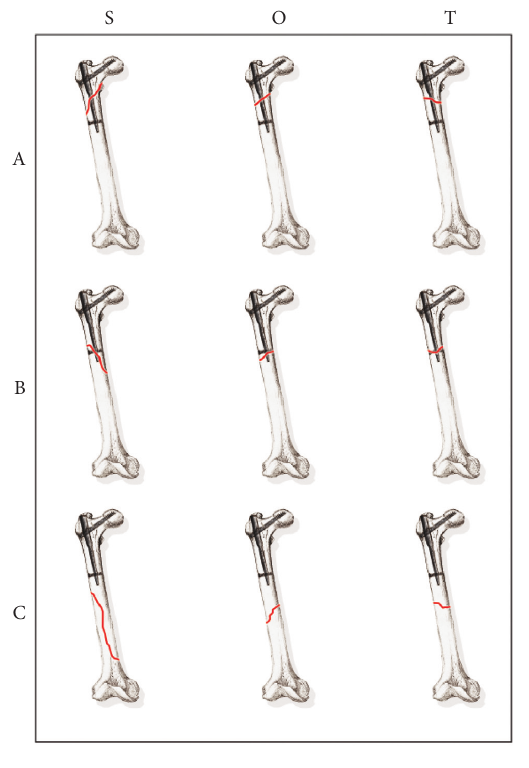
Figure 3: The main 9 types of PNFs.